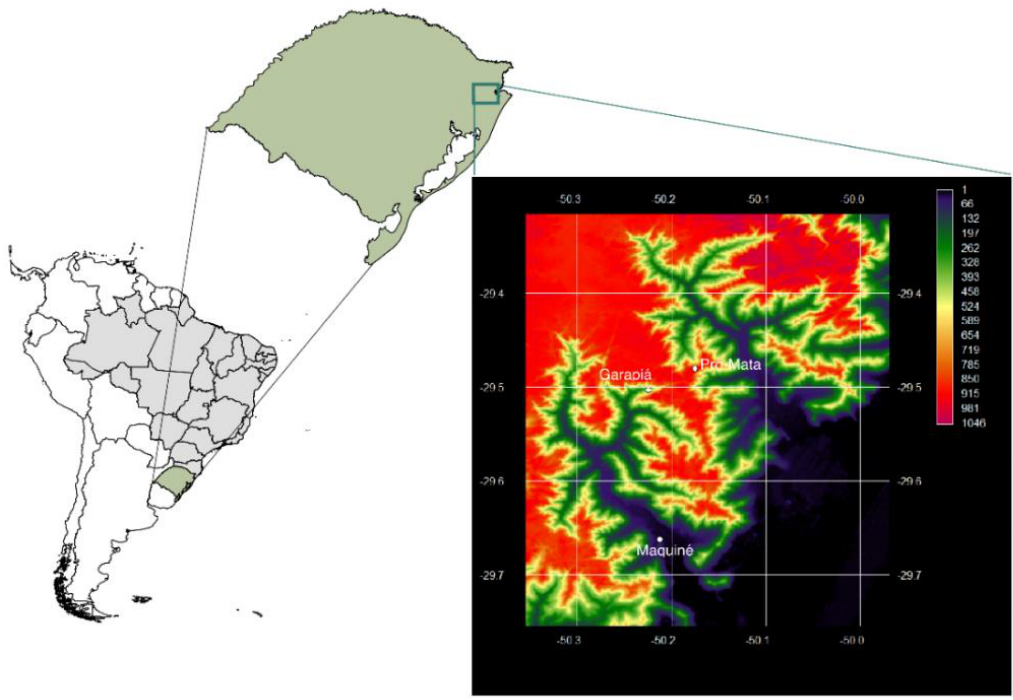
Figure 1. Sample sites at different altitudes in Serra Geral, Rio Grande do Sul, Brazil.